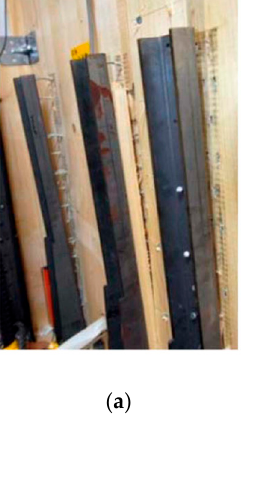
( b ) Figure 4. Timber panels damage observed in the quasi-static test of CLT buildings under large dis- placement: ( a ) embedment of wall panels into floor panels that causes the debonding of timber planks; ( b ) cracking in the corner of a large opening [19]. In addition to the impact on the structural deformability, the connectors were also proven to have a significant influence on the kinematic behaviours of CLT shear walls. According to the vertical and horizontal movements of panels measured in quasi-static tests, the kinematic behaviours of CLT shear walls on each floor are the combination of sliding and rocking, the proportions of which are varied according to the arrangement and properties of connectors [19,23]. It was reported that when panel rocking dominates the kinematic behaviour, better ductility, energy dissipation and ultimate displacement can be achieved, along with the self-centring of wall panels under their self-weight, mak- ing it superior to the sliding behaviour, which resulted in a significant residual lateral displacement [24,25]. Therefore, to achieve energy-dissipative kinematic behaviour in CLT shear wall systems, connections are the essential factors to be considered in the de- sign. Consequently, both dynamic [16,18,26] and static [19–23,25,27] tests on CLT panel- ised systems indicated that structures made of CLT panels generally demonstrated a high strength and stiffness, with most of the deformation and energy dissipation being devel- oped by the steel connections and the friction between timber panels, proving the feasi- bility of low-rise CLT construction in earthquake-prone regions. The governing role of steel connections in defining the overall structural performance necessitates the develop- ment of high-performing connections for reducing high accelerations of CLT buildings,